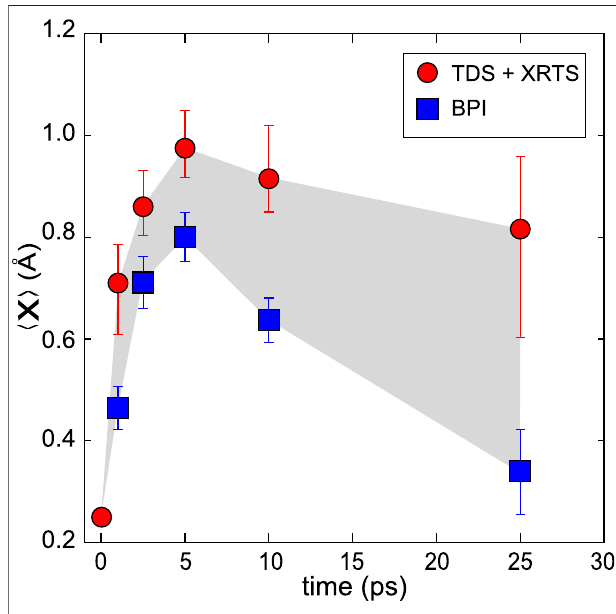
FIGURE 2 | Temporally resolved mean displacement as calculated from the total elastic XRTS signal at W R (k = 4.8 nm − 1 ) and the average Bragg peak intensity (BPI) measured at 40.5 ° , 43 ° , and 46 ° ; (blue circles) thermal diffuse scatter inferred from Bragg peak Intensity; (red circles) combination of XRTS and thermal diffuse scatter (TDS) as measured by the crystal spectrometer. Excess signal indicates total contribution from